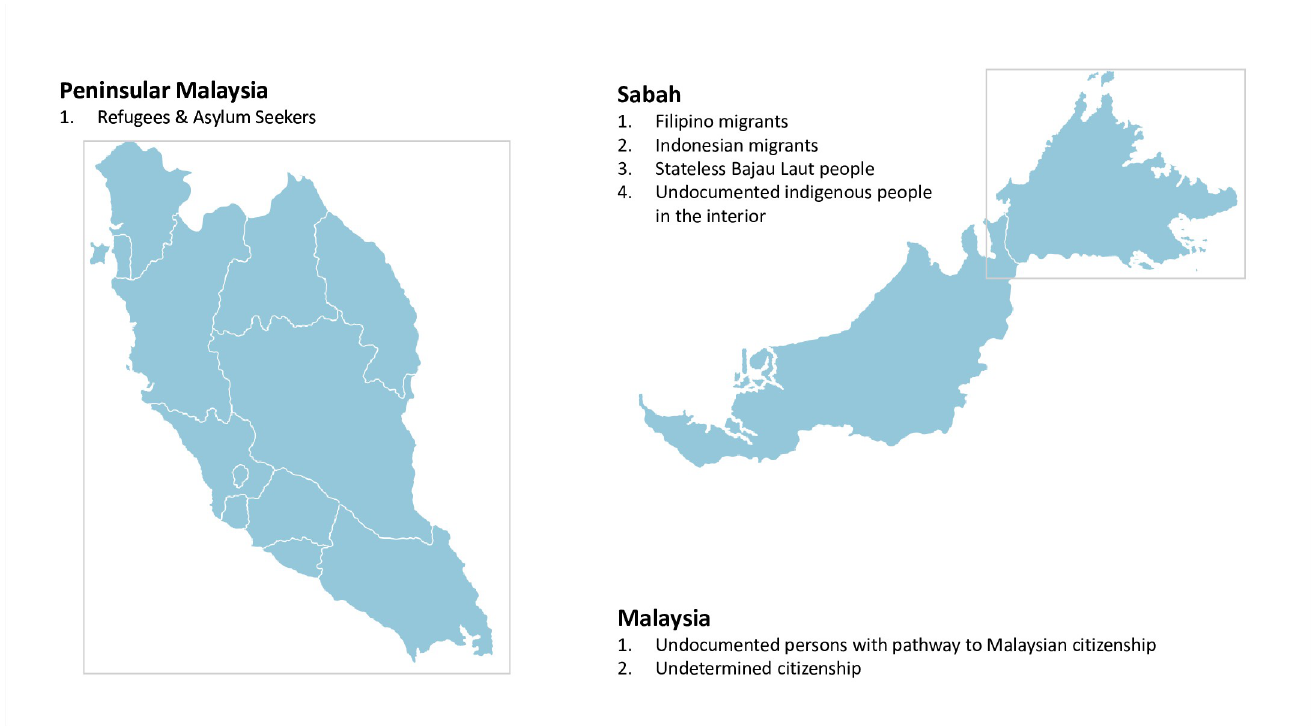
Fig 1. Different categories of undocumented and non-citizens children in Malaysia by location and legal identities. Note: Malaysia is comprised of Peninsular Malaysia and East Malaysia, separated by the South China Sea. Sabah is one of the states in East Malaysia. Reprinted from http://www.ofo.my/ under a CC by license, with permission from OFO Tech Sdn Bhd, original copyright